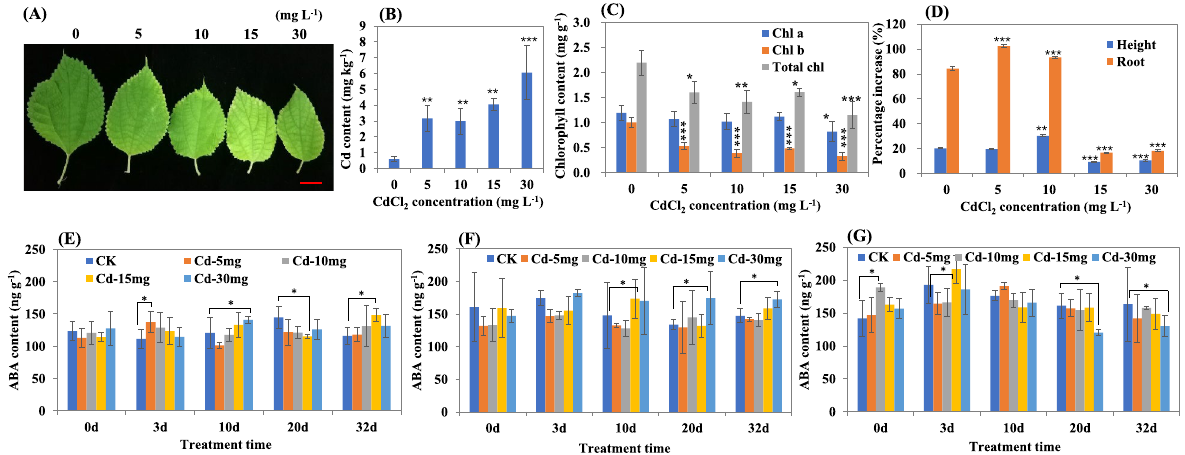
Figure 1. Phenotype and ABA content of ramie plants under Cd stress. ( A ) Phenotype of leaves under various concentration of Cd treatment. The red bar denotes 2 cm in length. ( B ) Cd content of shoots under Cd stress. ( C ) Chlorophyll content of the top fourth leaf under Cd stress. Data are means ± SD of three biological replicates. Each replicate consisted of material from five plants. ( D ) Increased rate of plant height and root. The values were calculated by the formula: 100·(V 20 − V 10 )/V 20 , V 10 and V 20 denote the value of plant height or root length after 10 and 20 days of Cd treatment, respectively. ( E ), ( F ) and ( G ) Changes of ABA content in new leaf, old leaf and root, respectively. Data are means ± SD of three biological replicates. Each replicate consisted of material from ten plants. *, ** and ***denote statistically significant differences from the control (0 mg L −1 ) at P < 0.05, P < 0.01 and P < 0.001,